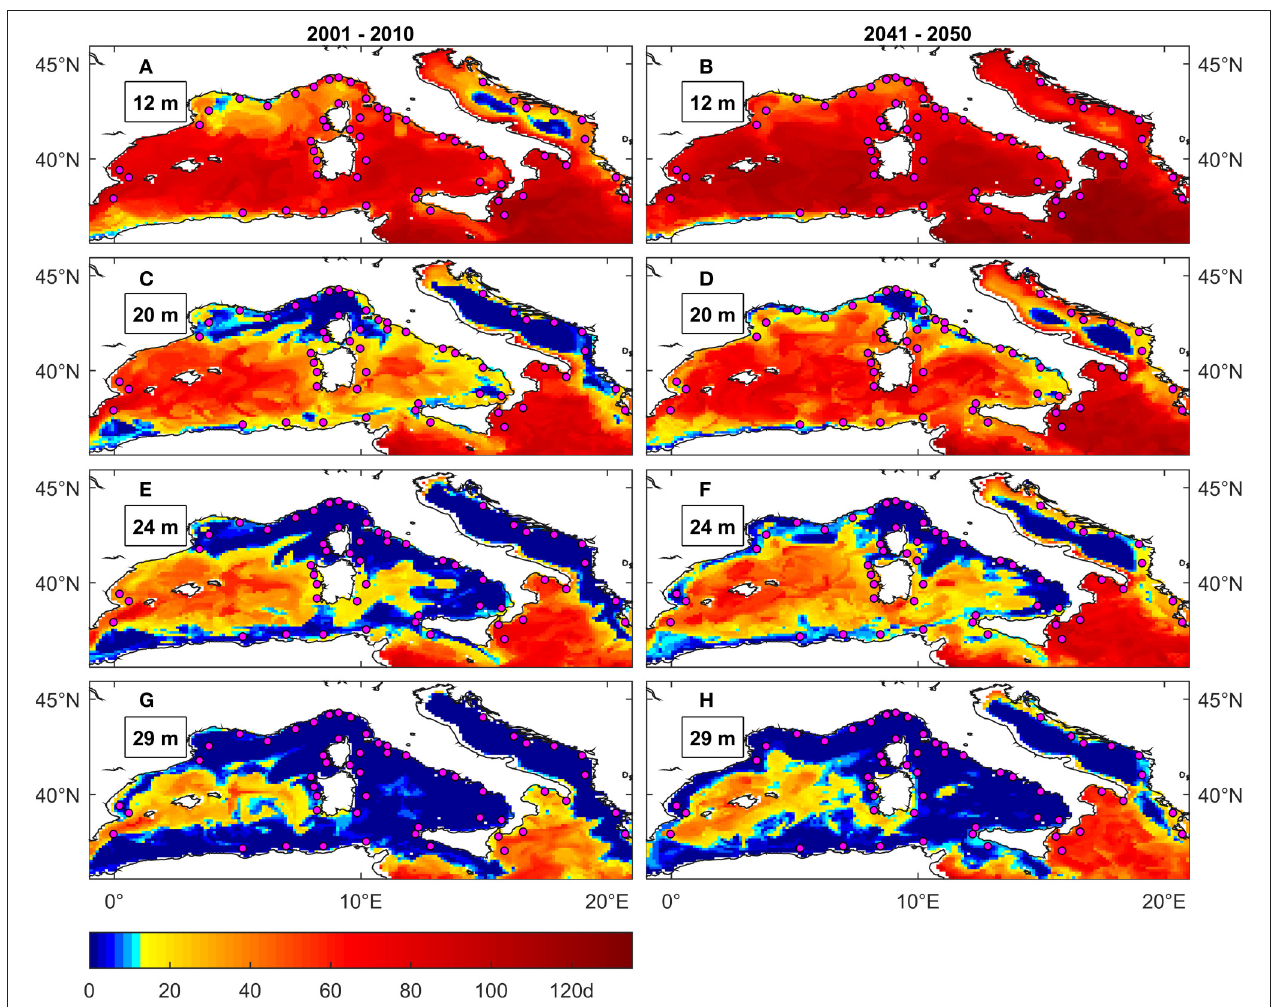
FIGURE 5 | Maximal number of consecutive days above 25 ◦ C in NW Mediterranean and Adriatic under present (A,C,E,G) and future (B,D,F,H) conditions at different depths. The colormap is modified to highlight the duration threshold of 12 days that is the average of the values (9 and 14 days) identified in Torrents et al. (2008) as critical for C. rubrum deep and shallow populations survival respectively. Magenta circles are C. rubrum presence records (Harmelin,